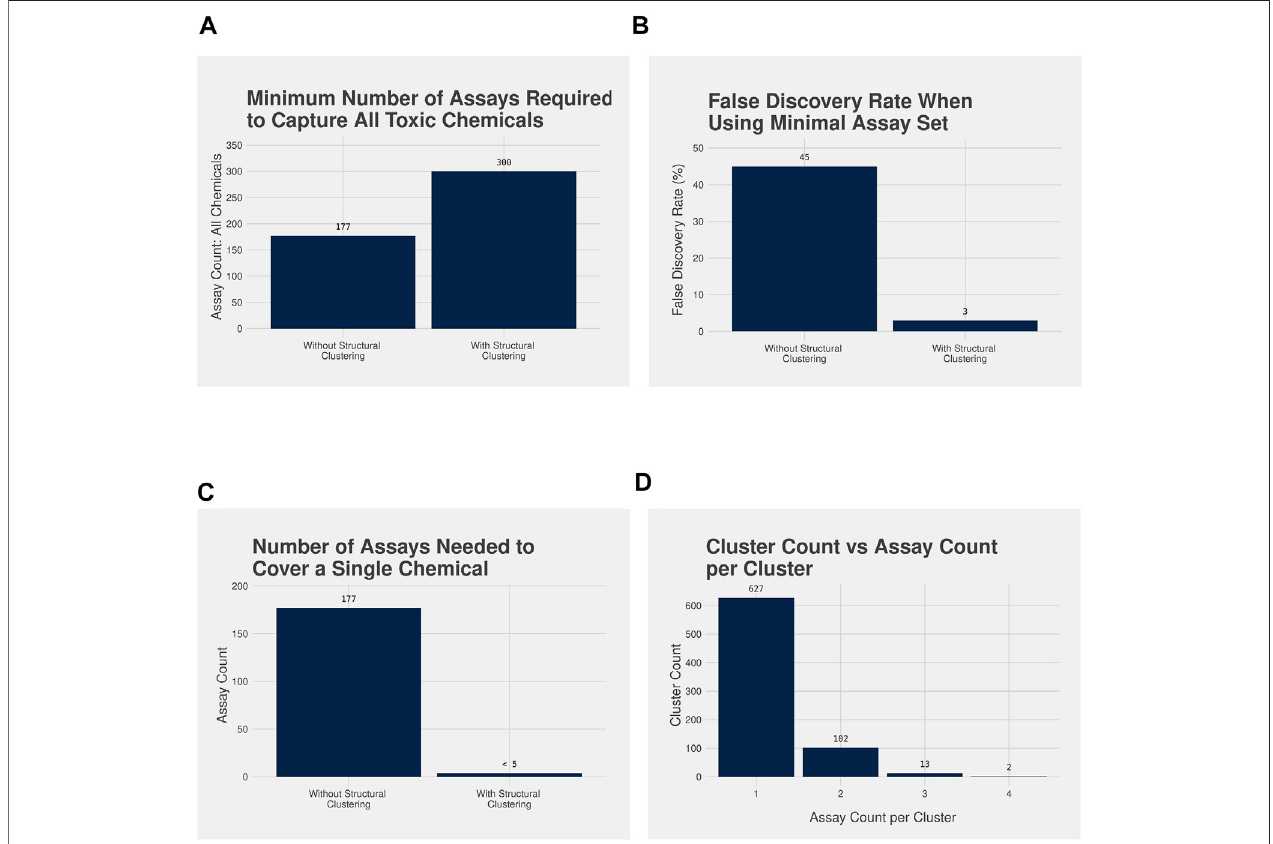
FIGURE 3 | (A) Bar plot illustrating the minimum number of assays required to identify all acutely toxic chemicals after performing the assay analysis work fl ow without(177assays)andwith(300assays)thestructure-basedclustering,and (B) barplotillustratingthefalsediscoveryrate(FDR)associatedwiththeminimalassayset without (45%) and with (3%) the structure-based clustering. A larger number of assays are required to capture all acutely toxic chemicals with the structure-based clustering,buttheFDRisdramaticallyreducedwhencomparedwithnotusingthestructure-basedclusters. (C) Barplothighlightingthenumberofassaysrequired to assess the potential acute toxicity of a single chemical without using the structural clustering compared with when the structural clustering is used, and (D) Bar plot illustrating the number of chemical clusters requiring testing in 4 or fewer assays to cover all acutely toxic chemicals, with bioactivity data in ToxCast. Without structural clusteringanovel chemical would berequired tobetested inall177assaysinthe minimalassayset. With theclusterinformation fewer than 5assayswould be required: 98% of clusters would only need testing in 1 or 2 assays.